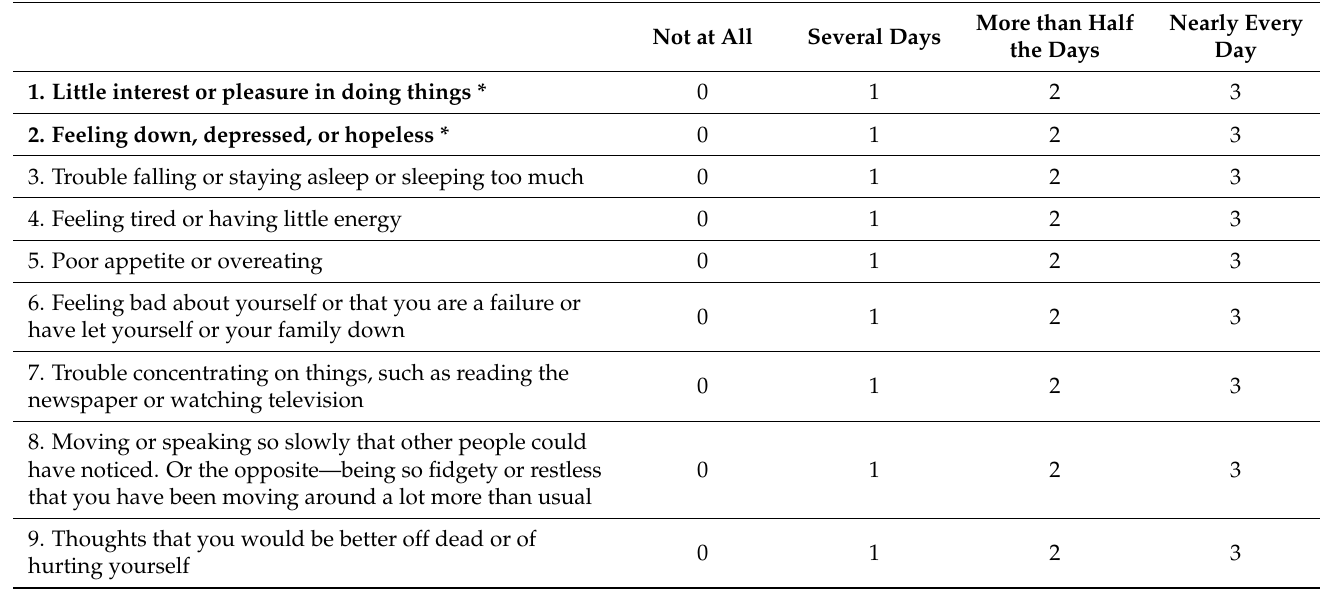
Table A3. The Patient Health